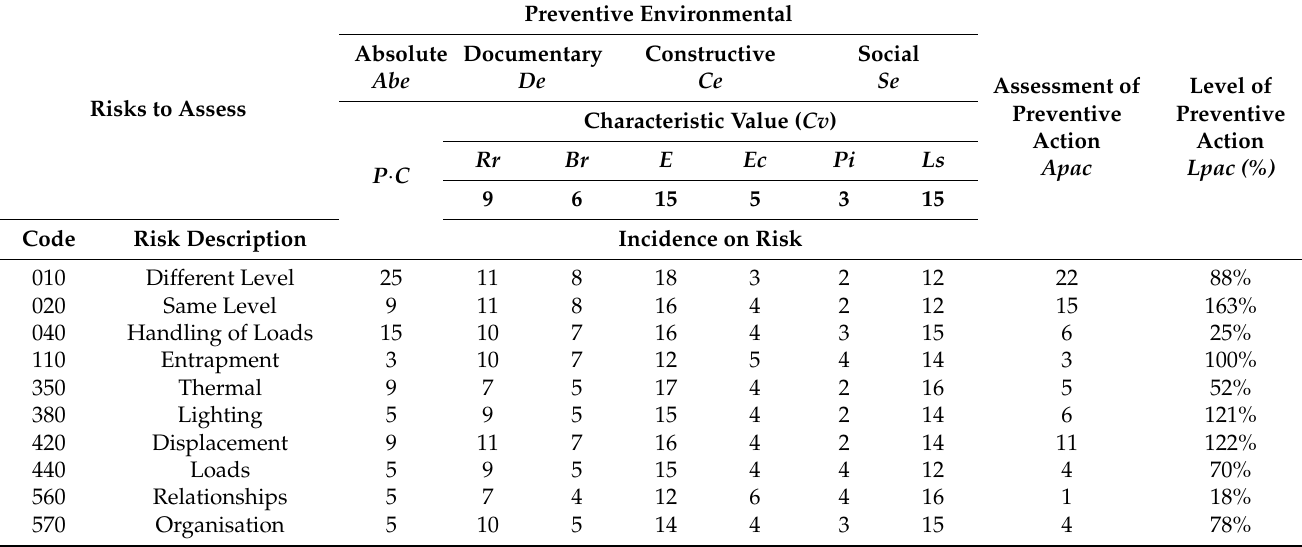
Table 8. Incidence of Cv on